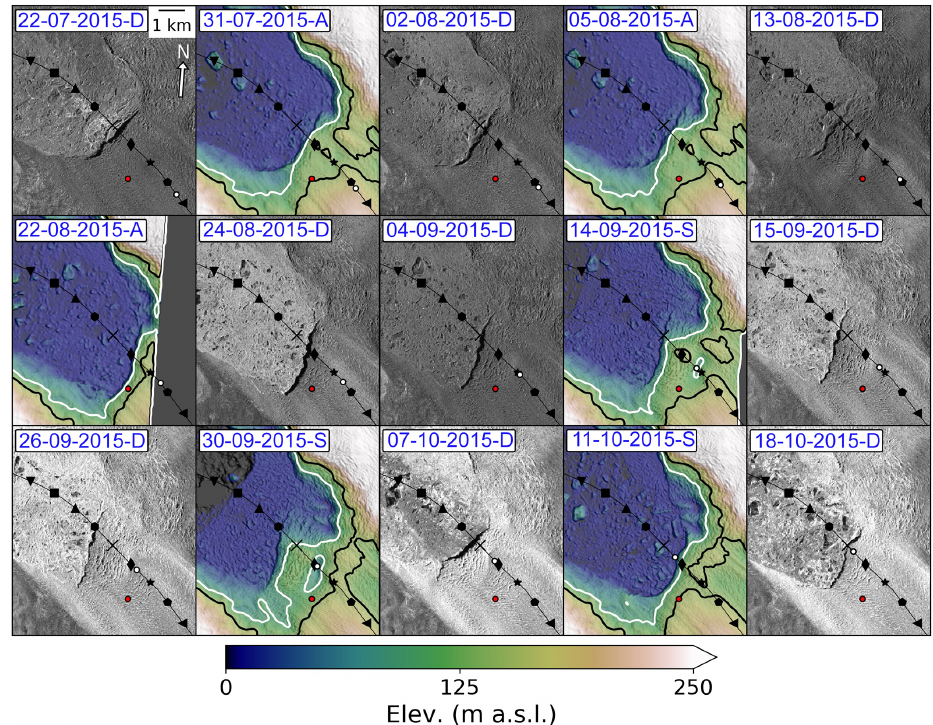
Figure 8. Time series of TerraSAR-X SAR backscatter amplitude imagery and colour-shaded relief maps for late summer 2015 identified by date of acquisition (DD-MM-YYYY). The source of the data in each map is indicated by the letter after each date (D: TerraSAR-X images, copyright DLR, 2015; A: ASP WorldView DEM; S: SETSM WorldView DEM). The artificial illumination source for the DEM-shaded surfaces was chosen to approximate the illumination angle of the TerraSAR-X radar. Note that the terminus in the radar imagery casts a true shadow, while the corresponding shadows in the shaded relief maps are based on the local slope and aspect. The red circle shows the location of M6, while the white circle tracks the parcel of ice that evolved to form the depression (e.g. 30 September) described in the text (see the triangles in Fig.